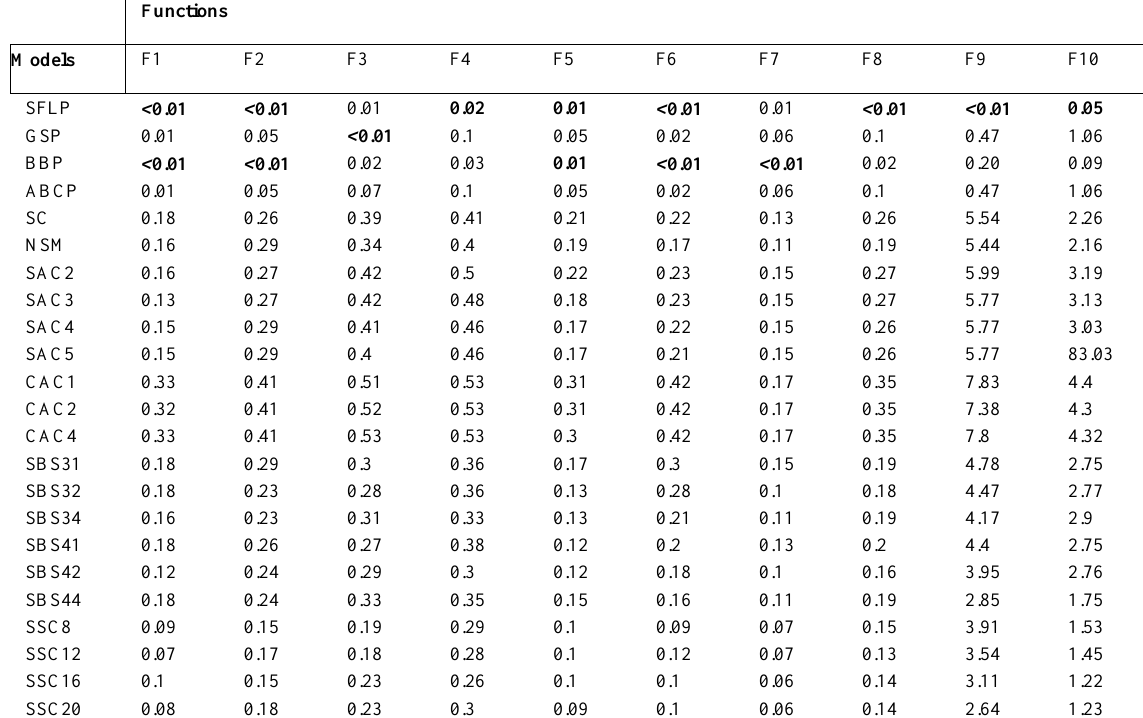
Table 5. Mean best fitness values of SFLP and other mentioned methods with parameter setting of 𝑵𝒔𝒕𝒆𝒑 = 𝟓𝟎,𝒒 = 𝟐, 𝒎 = 𝟏𝟎𝟎,𝒂𝒏𝒅 𝒏 = 𝟓 .